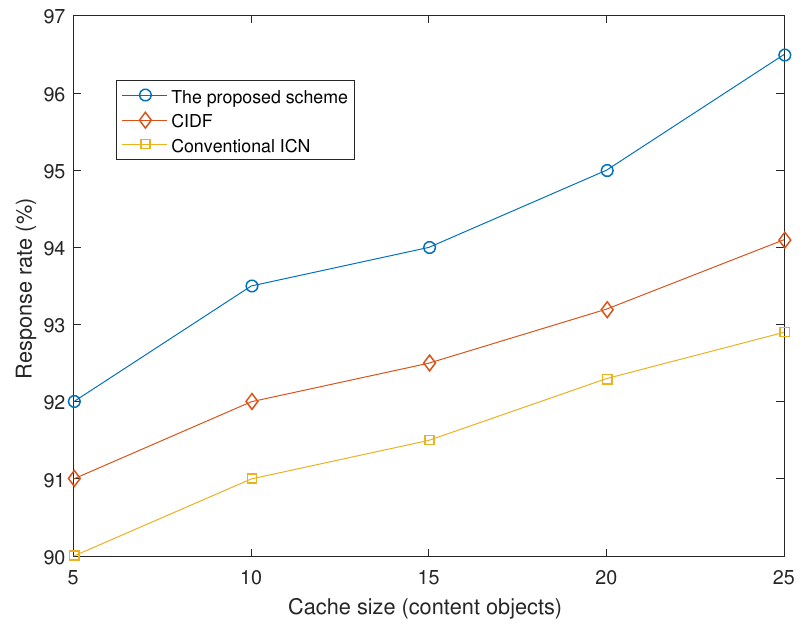
Figure 6. Response rate vs. cache